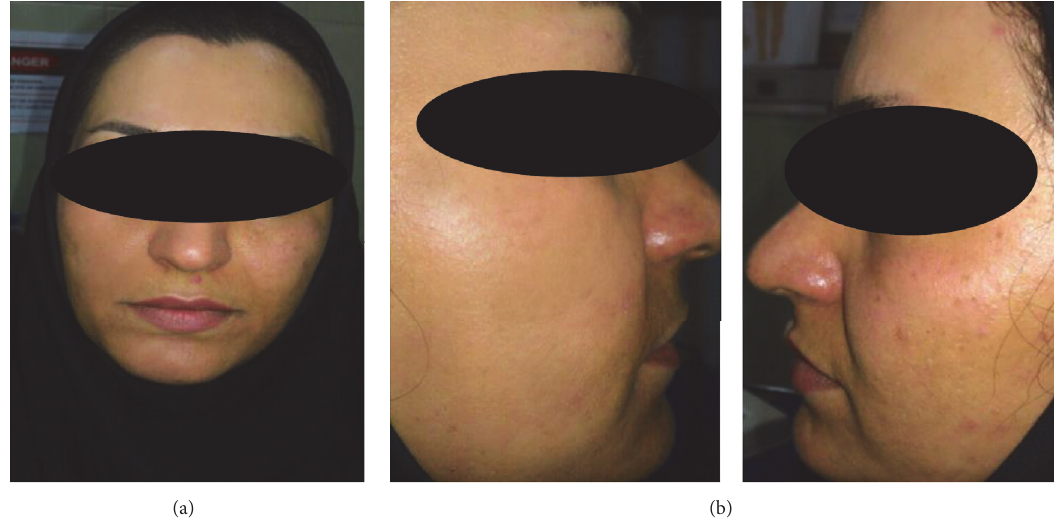
Figure 1: Clinical appearance of facial skin in a 37-year-old female with advanced photoaging at 6 months after (a) microdermabrasion and (b) 5% retinoic acid peel combined with microdermabrasion.